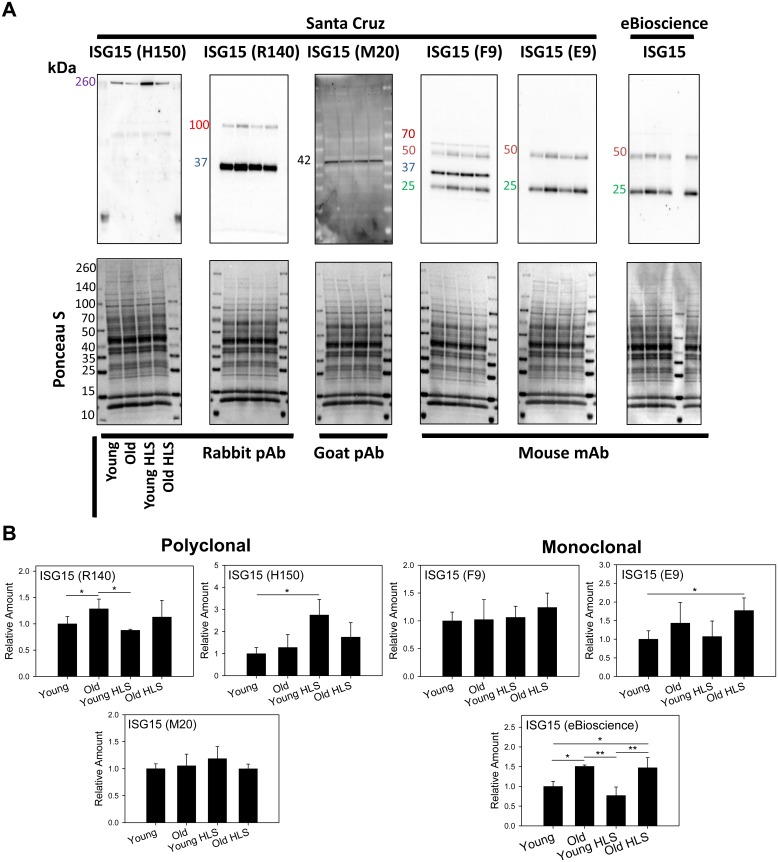
Comparison of anti-ISG15 antibodies.(A) Seven anti-ISG-15 antibodies were used to detect the levels of ISGylated proteins in four different types of samples. (B) Quantification of ISG15 Western blots. Young, 10 month old hearts; Young HLS, high-limb suspended 10 month old hearts; old, 30 month old hearts; Old HLS, high-limb suspended 30 month old hearts. * p < 0.05, ** p < 0.01 by 1-way ANOVA.